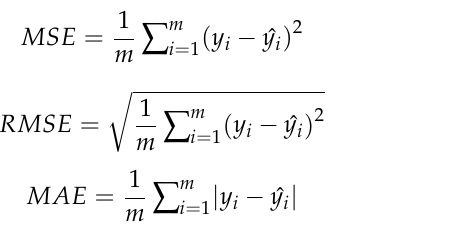
Table 4. Super parameter values of the GRU model. Number of Activation Learning Optimizer Batch Size Epoch Neurons Function Rate 180 Sigmoid Adam 0.001 1